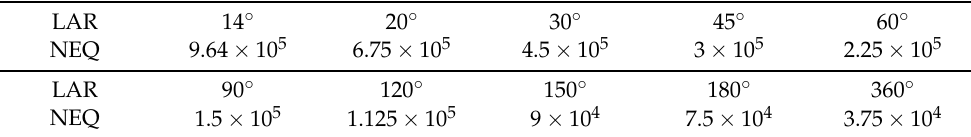
Table 1. NEQs per detector bin in air scans of either the low- or high-kVp scans for the chest and suitcase phantoms with LARs ranging from 14 ◦ to 180 ◦ , as well as with the FAR of 360 ◦ . LAR 14 ◦ 20 ◦ 30 ◦ 45 ◦ NEQ